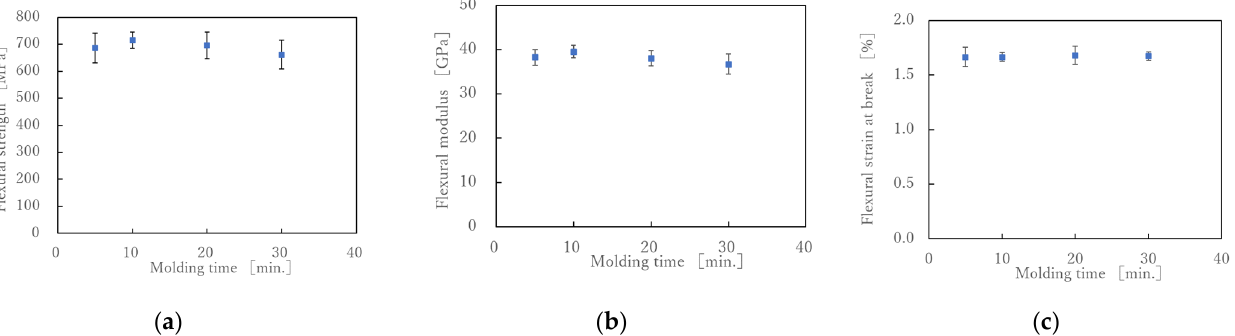
Figure 11. ( a ) Effect of molding time on flexural strength under molding pressure of 5 MPa.; ( b ) Effect of molding time on flexural modulus under molding pressure of 5 MPa and ( c ) Effect of molding time on flexural strain at break under molding pressure of 5 MPa.